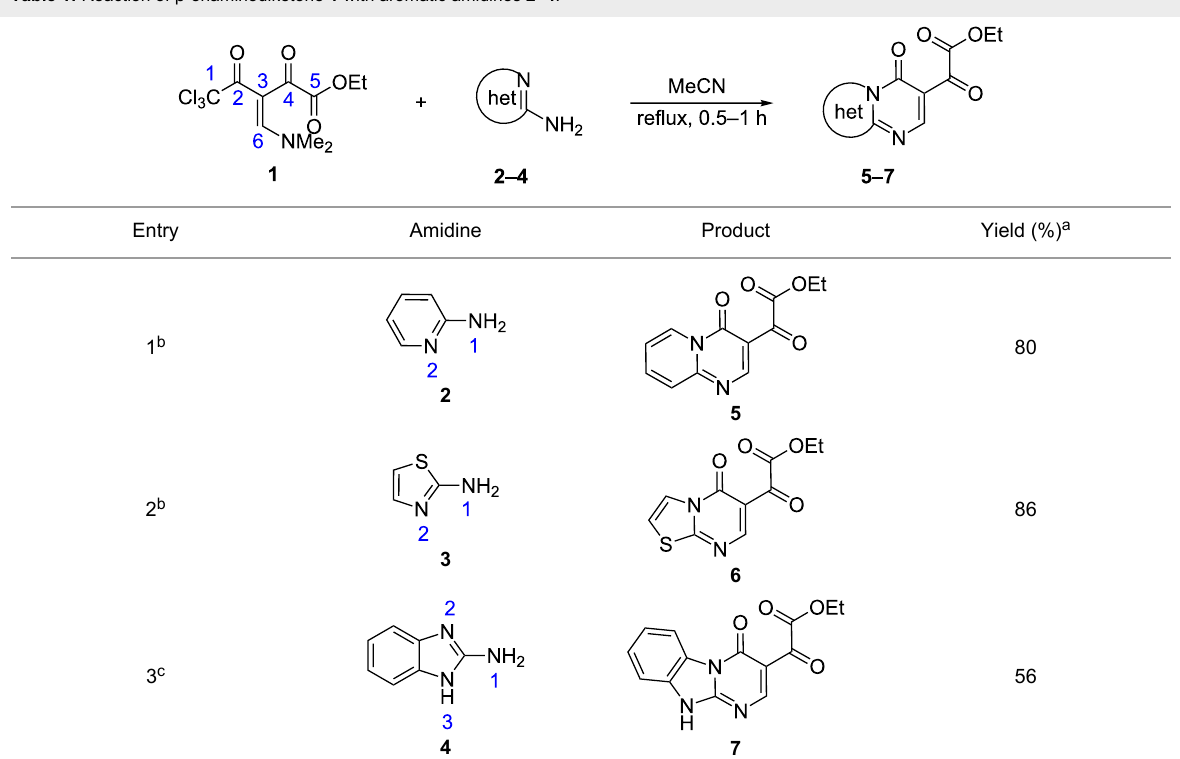
Table 1: Reaction of β -enaminodiketone 1 with aromatic amidines 2 – 4